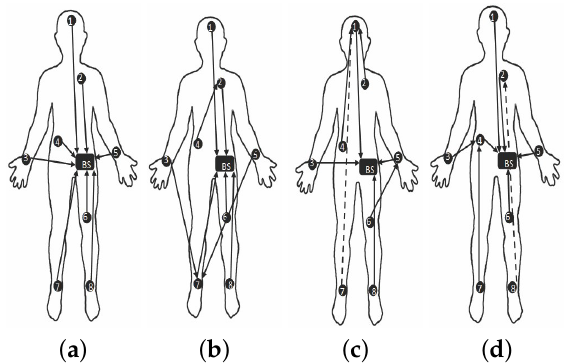
Figure 23. Typical network topology while sleeping activity. ( a ) At TX 1 ; ( b ) At TX 2 ; ( c ) At TX 3 ; ( d ) At TX 4